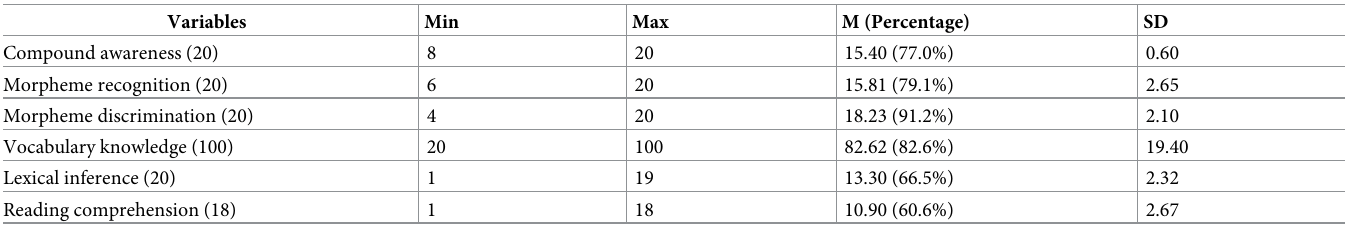
Table 1. Descriptive statistics of morphological awareness, vocabulary knowledge, lexical inference and reading